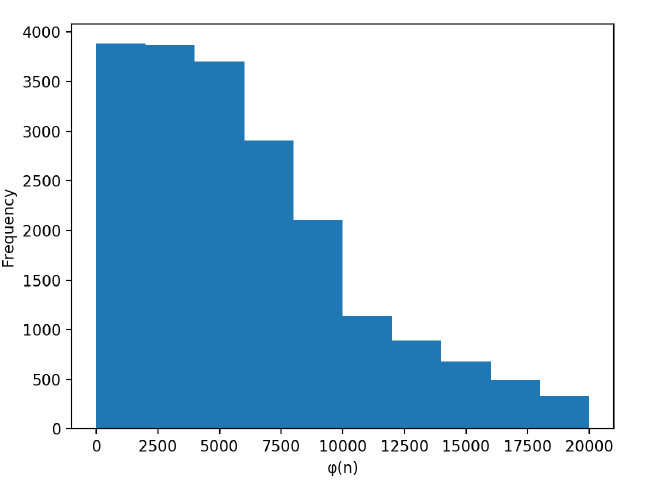
Figure 7. The Cardinal of the Inverse of Euler